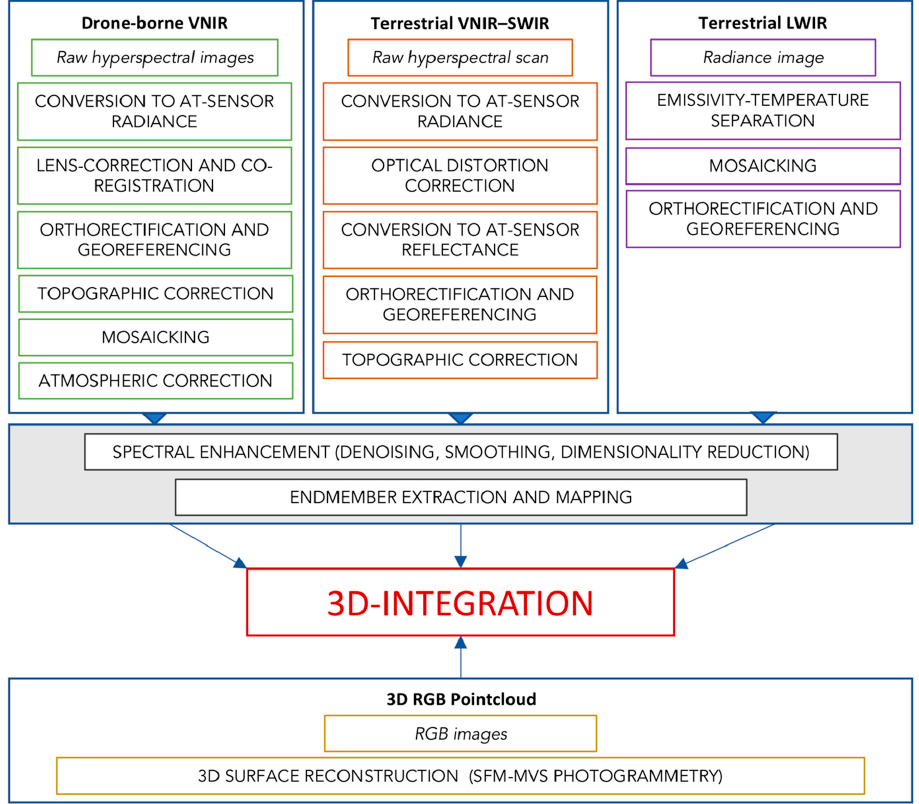
Figure 3. Schematic processing workflow for the integration of VNIR–SWIR–LWIR hyperspectral data and SfM photogrammetric point clouds.